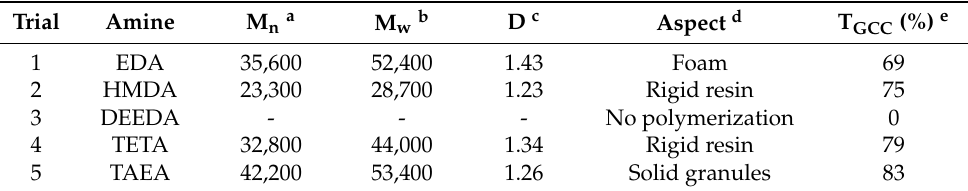
Table 1. One-pot strategy; Influence of the amine on the synthesis of glycerol amino ethylene ester PHUs. T = 90 ◦ C, duration = 2 h.